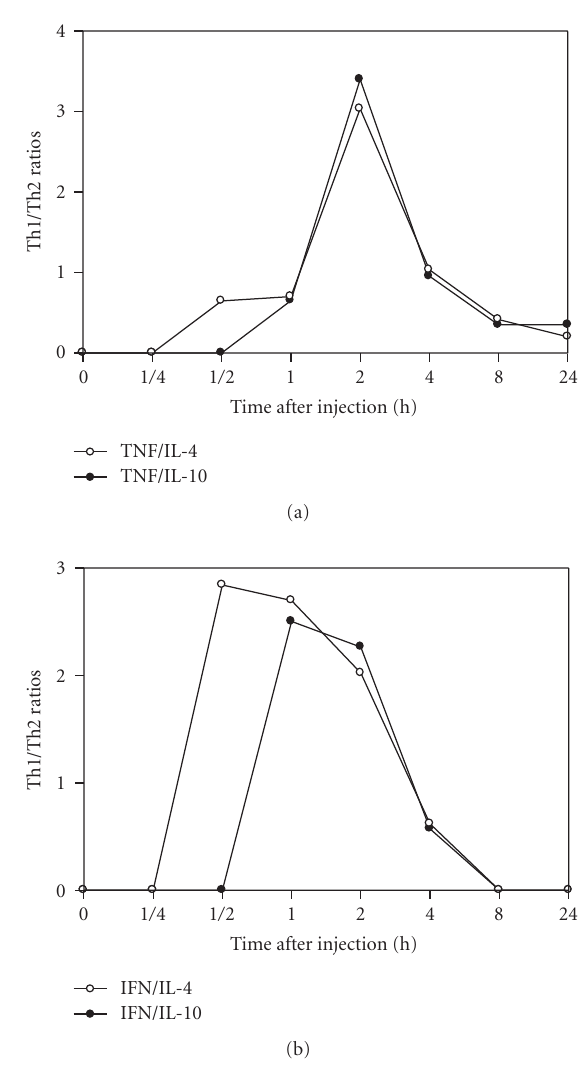
Figure 7: Pro-/anti-inflammatory cytokine balance . The serum levels of cytokines were determined as described in materials and methods (see Section 2). The ratios of pro-/anti-inflammatory; IFN- γ /IL-4, IFN- γ /IL-10, TNF- α /IL-4, and TNF- α /IL-10 represent the values of samples from two experiments in di ff erent groups of five to fifteen